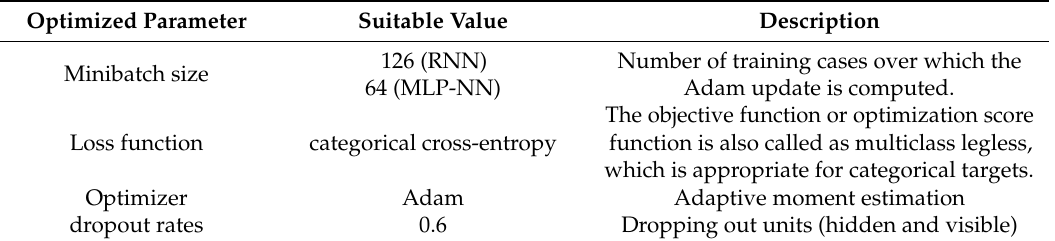
Table 2. Optimized model hyper-parameters; RNN: recurrent neural networks, MLP-NN: multi-layer perceptron neural